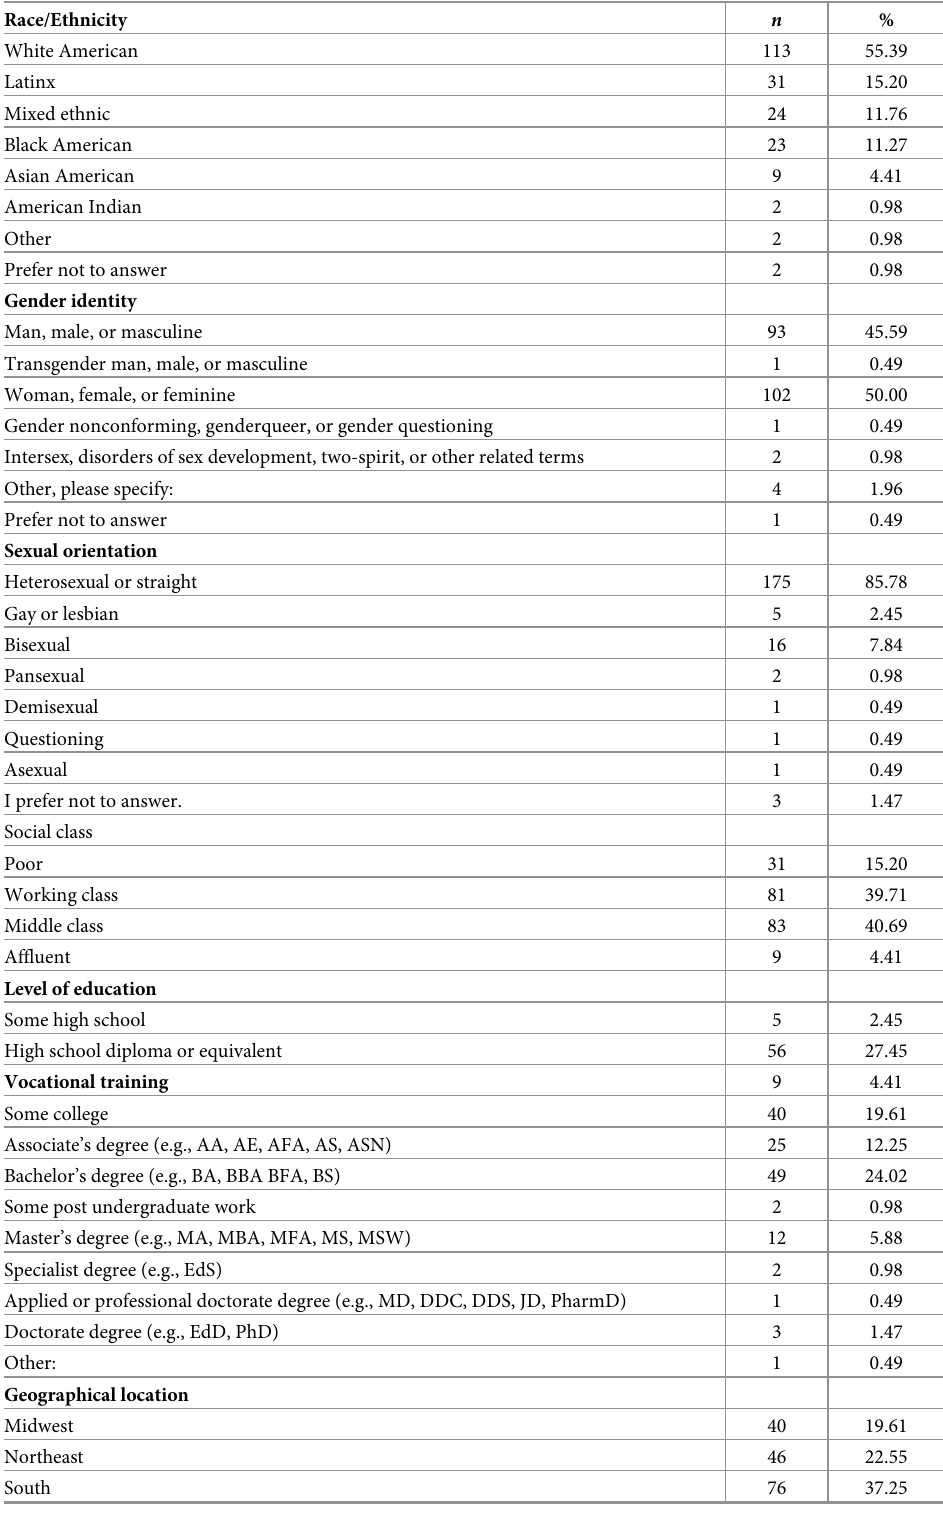
Table 1. Sample demographic characteristics ( N =